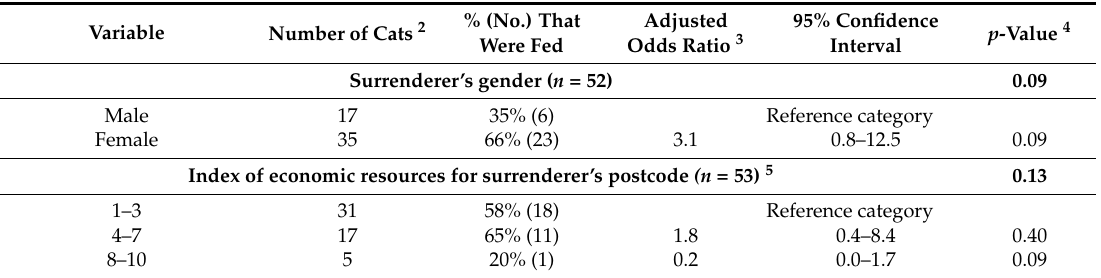
53 unowned Table 6. Putative determinants 1 of whether the surrenderer fed the cat that was surrendered for 53 unowned cats.